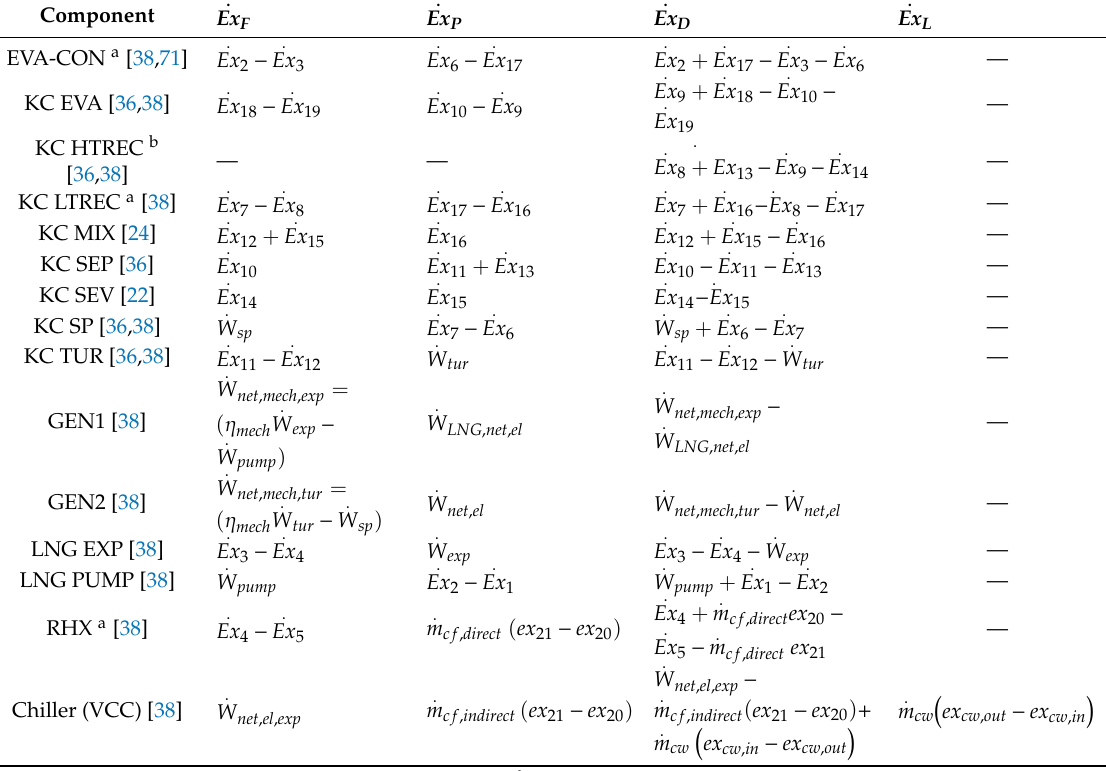
Table A2. Exergy relations for the poly-generation system